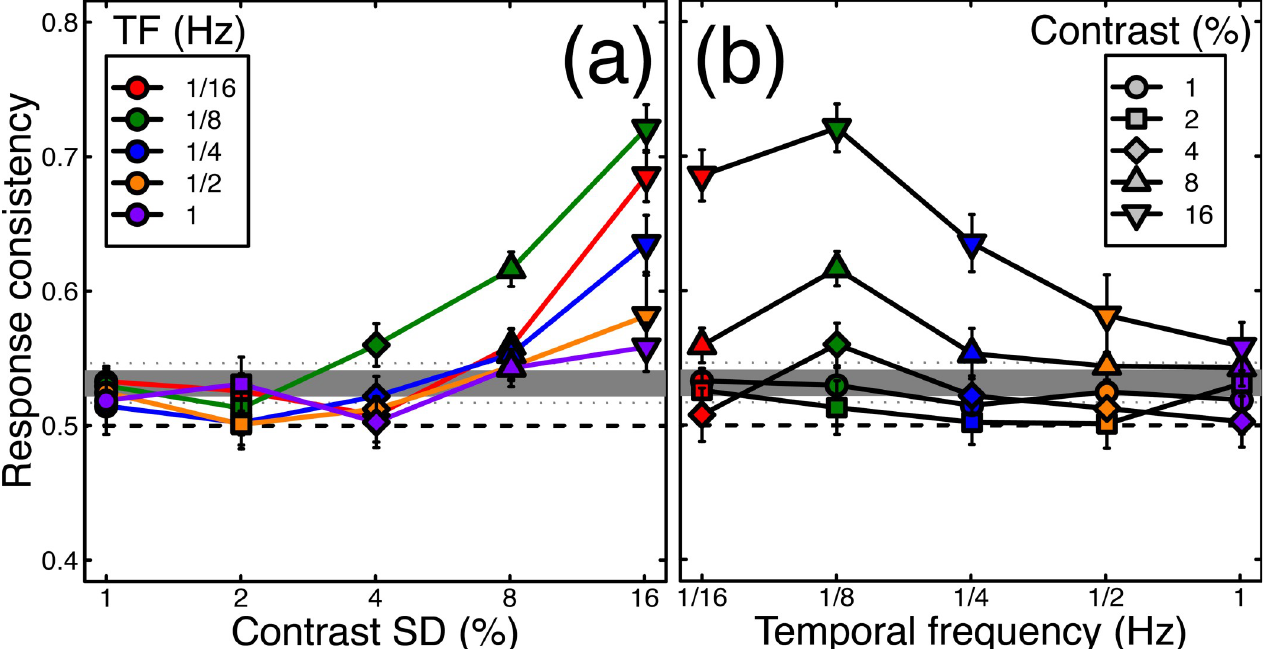
Fig 4. Response consistency across two passes through the experiment. The same data are plotted in both panels, as a function of modulation contrast (a) or temporal frequency (b). In each panel, the thick grey line represents the baseline (no modulation) condition, colours represent different temporal frequencies, and symbol types represent different contrasts. All data points are averaged across participants, with error bars indicating ± 1SE of the mean. The dashed horizontal line at y = 0.5 indicates a theoretical baseline in the absence of any response bias or eye dominance effects.